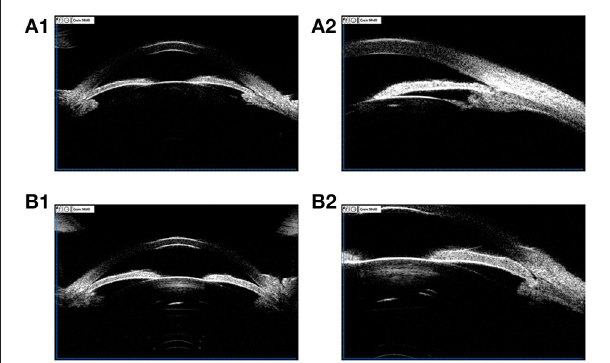
FIGURE 2 | (A1,A2) UBM images of a 36-year-old female PACG patient. ACD 1.93mm, ACW 10.77mm, LV 0.869mm, PD 2.17mm, AOD 0.02mm,